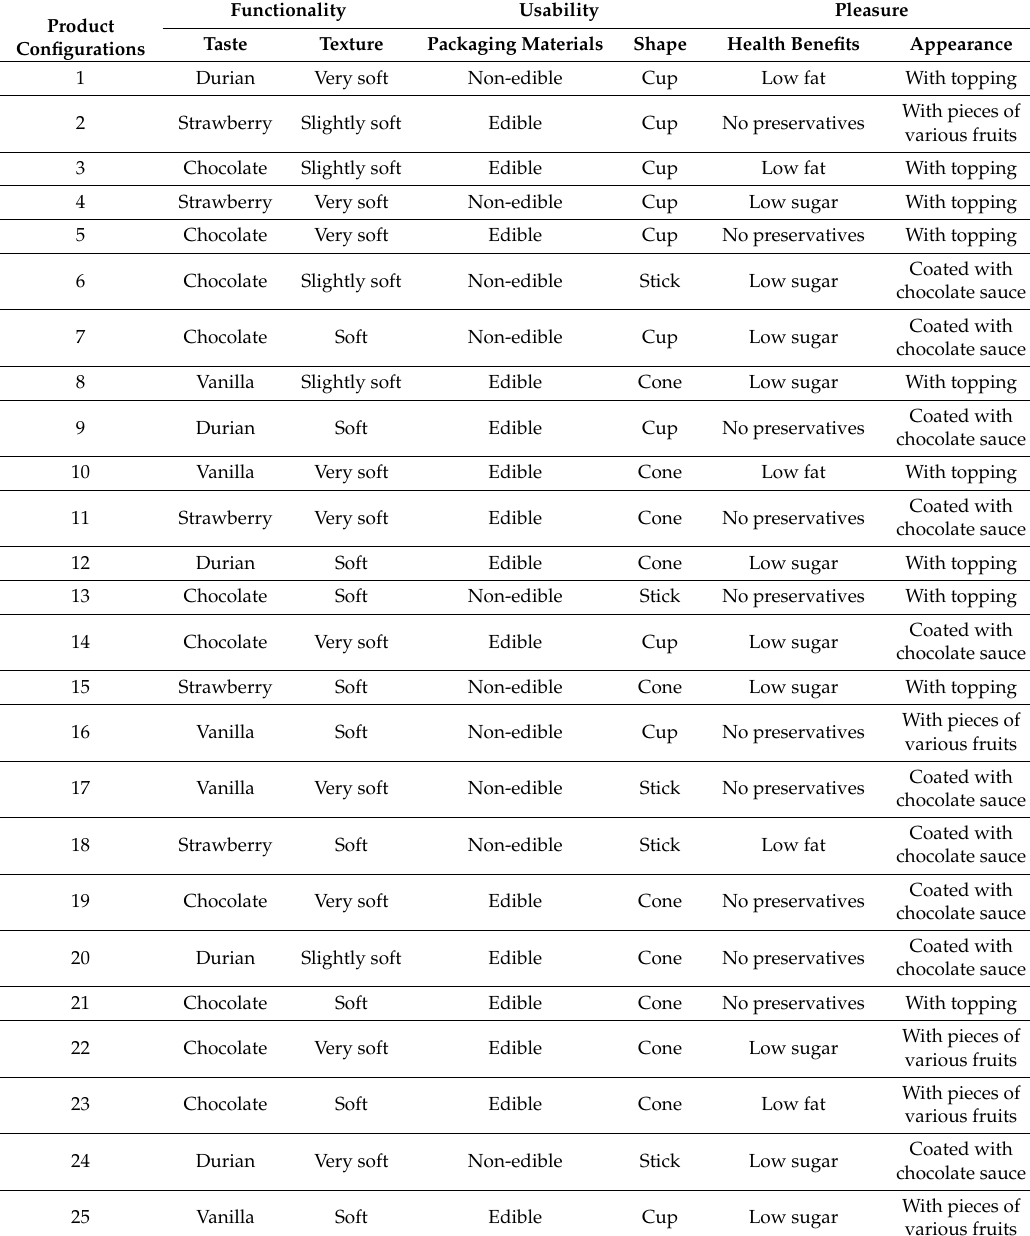
Table 6. Alternative product